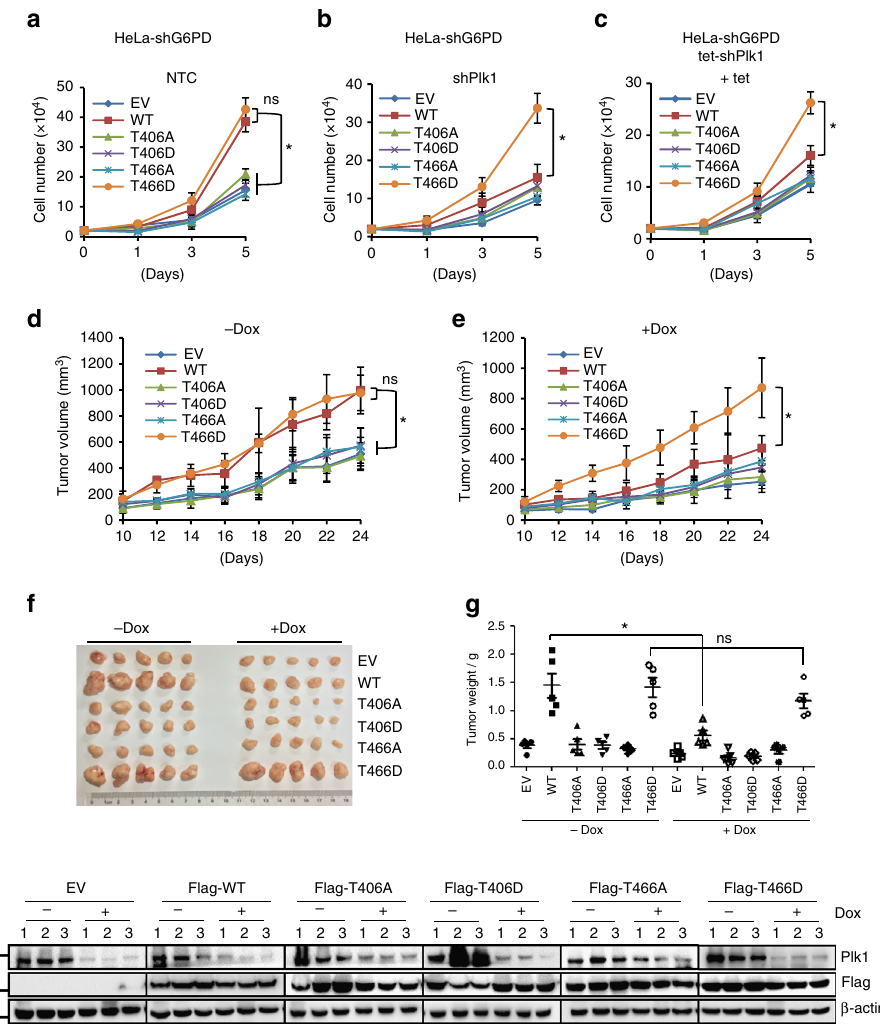
Fig. 7 G6PD is critical for Plk1-mediated tumor proliferation in vivo. a , b HeLa cells stably expressing shG6PD were infected with viruses expressing pSin- 3xFlag-G6PD wild type or mutants together with viruses expressing NTC ( a ) or shPlk1 ( b ) as indicated. Cell numbers were counted by trypan blue staining. n = 3 biologically independent replicates. Data were presented as mean ± s.d. * P < 0.05 as compared between indicated groups by two-sided Student ’ s t - test. c HeLa cells stably expressing shG6PD were infected with viruses expressing pSin-3xFlag-G6PD wild type and mutants together with viruses expressing tet-inducible shPlk1 as indicated. Cells were treated with 0.1 μ g/ml doxycycline and cell numbers were counted by trypan blue staining. n = 3 biologically independent replicates. Data were presented as mean ± s.d. * P < 0.05 as compared between indicated groups by two-sided Student ’ s t -test. d – g HeLa cells stably expressing shG6PD were infected with viruses expressing pSin-3xFlag-G6PD wild type and mutants together with viruses expressing tet-inducible shPlk1 as indicated. Equal numbers of cells were subcutaneously injected into nude mice ( n = 5 for each group). The mice were treated with or without doxycycline (1 mg/ml) in drinking water staring from 1 day before inoculation. The doxycycline-containing water was freshly prepared every